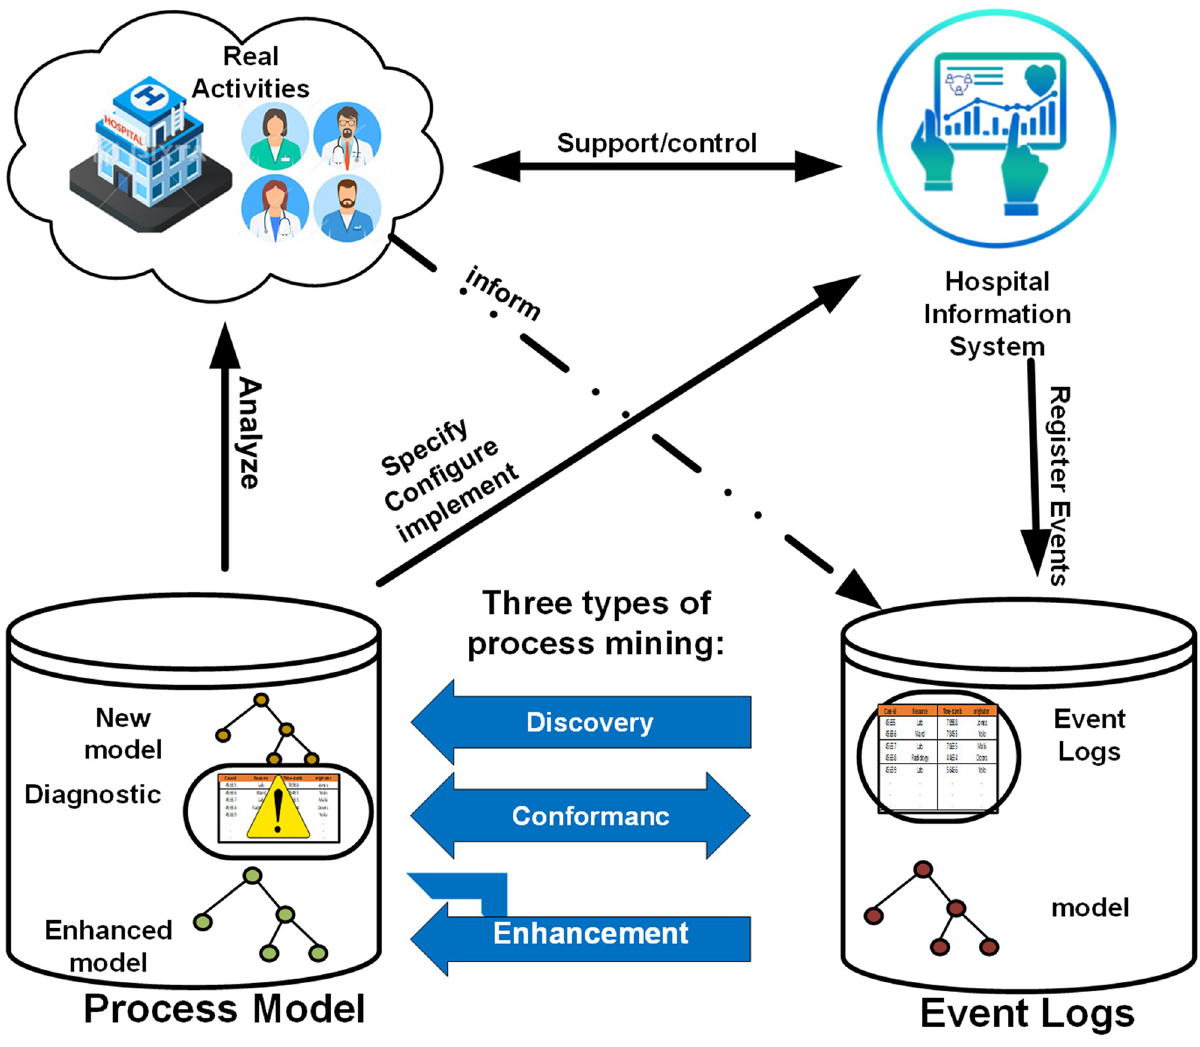
Fig 1. Process mining approach including process discovery, conformance checking and enhancements for a hospital [7].